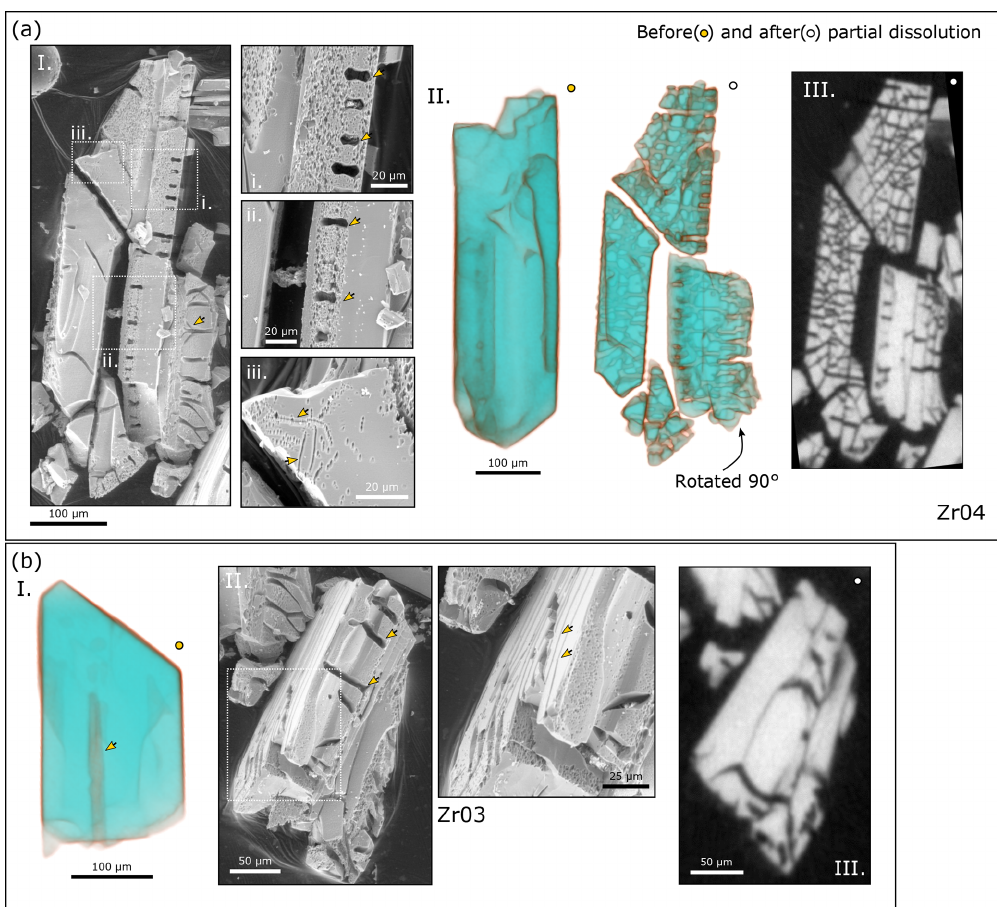
Figure 10. SE and µCT images of AS3 grains pre- and post-chemical abrasion at 210 ◦ C for 4h. (a) Subpanel (I) shows SE images of Zr04, a large crystal broken into four pieces. The rotated piece marked with a yellow arrow shows a nice cross section of the grain interior. The arrow highlights an example of a branching channel. The higher-magnification images show that these channels correlate with dumbbell features that cross-cut zones of relatively low (box i) or high (box ii) radiation damage. Box (iii) shows etch pit arrays likely indicative of dislocation loops or low-angle grain boundaries. (II) 3D rendering of the µCT data showing the development of a complex dissolution network in the crystal’s interior. (III) 2D µCT image slice showing that the intensive fracturing observed in 3D is restricted to a narrow plane within the crystal. (b) Subpanel (I) shows a semi-transparent 3D rendering of µCT data for Zr03, showing a large melt inclusion. (II) SE images show elongated, channel-like dumbbells (low magnification) and the apparent removal of fine-scale zones (high magnification). (III) 2D µCT image slice showing wide acid paths in the grain